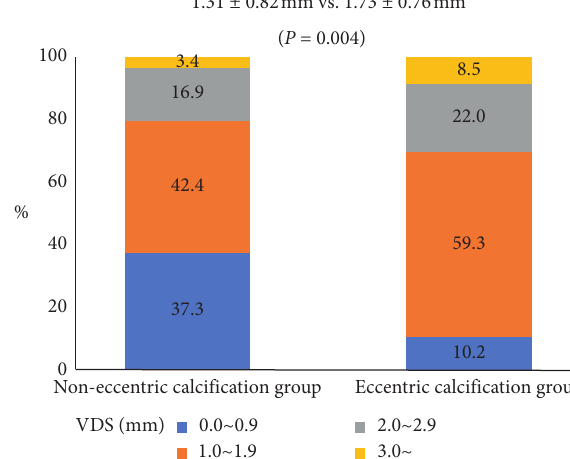
Figure 2: The effects of aortic valvular calcium eccentricity on the valve distortion score. Valve distortion score (VDS) was signifi- cantly lower for the noneccentric calcification group compared with those of the eccentric calcification